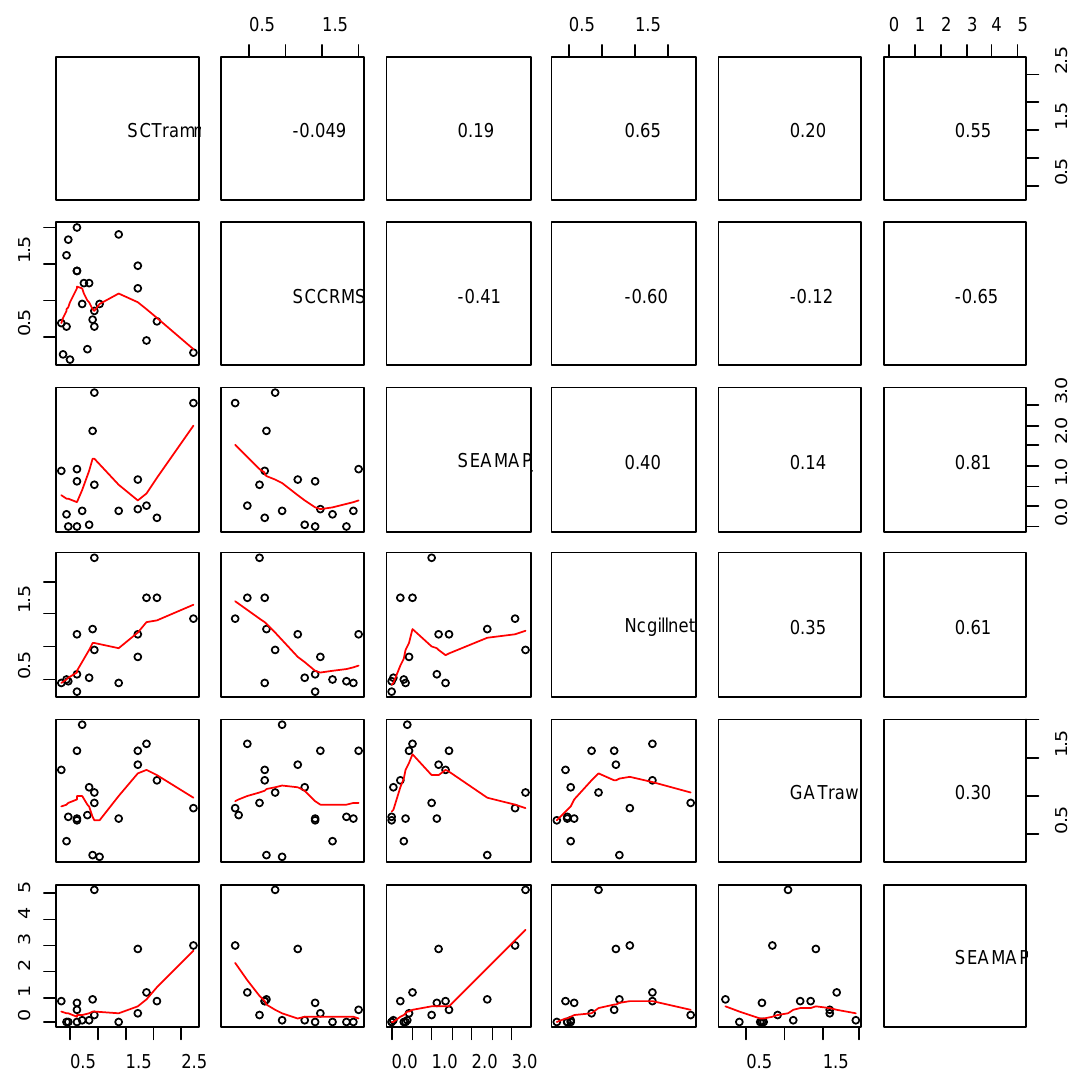
Figure 76. Correlation coefficients and scatter plots for the horseshoe crab abundance indices in the Southeast Region for 1995-2017. All correlations are insignificant ( P >0.05) except for the correlations between the North Carolina Gill Net and South Carolina Trammel indices ( P =0.036), the North Carolina Gill Net and South Carolina CRMS indices ( P =0.010), and SEAMAP’s South Carolina and Georgia-Florida indices ( P